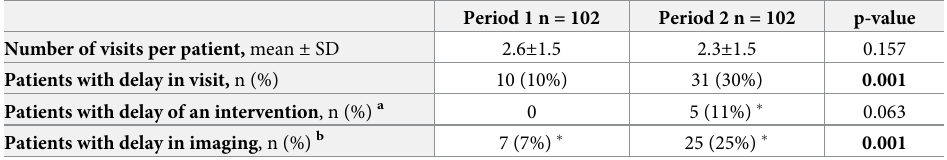
Table 2. Impact of COVID-19-related healthcare restrictions on patient management. Period 1 n = 102 Period 2 n = 102 p-value Number of visits per patient, mean ± SD 2.6 ± 1.5 2.3 ± 1.5 0.157 Patients with delay in visit, n (%) 10 (10%) 31 (30%) 0.001 Patients with delay of an intervention , n (%) a 0 5 (11%) � 0.063 Patients with delay in imaging , n (%) b 7 (7%) � 25 (25%) � 0.001 a Interventions performed in n = 47 patients. b Data available in n = 101 patients. � Percentages calculated from respective sample sizes.